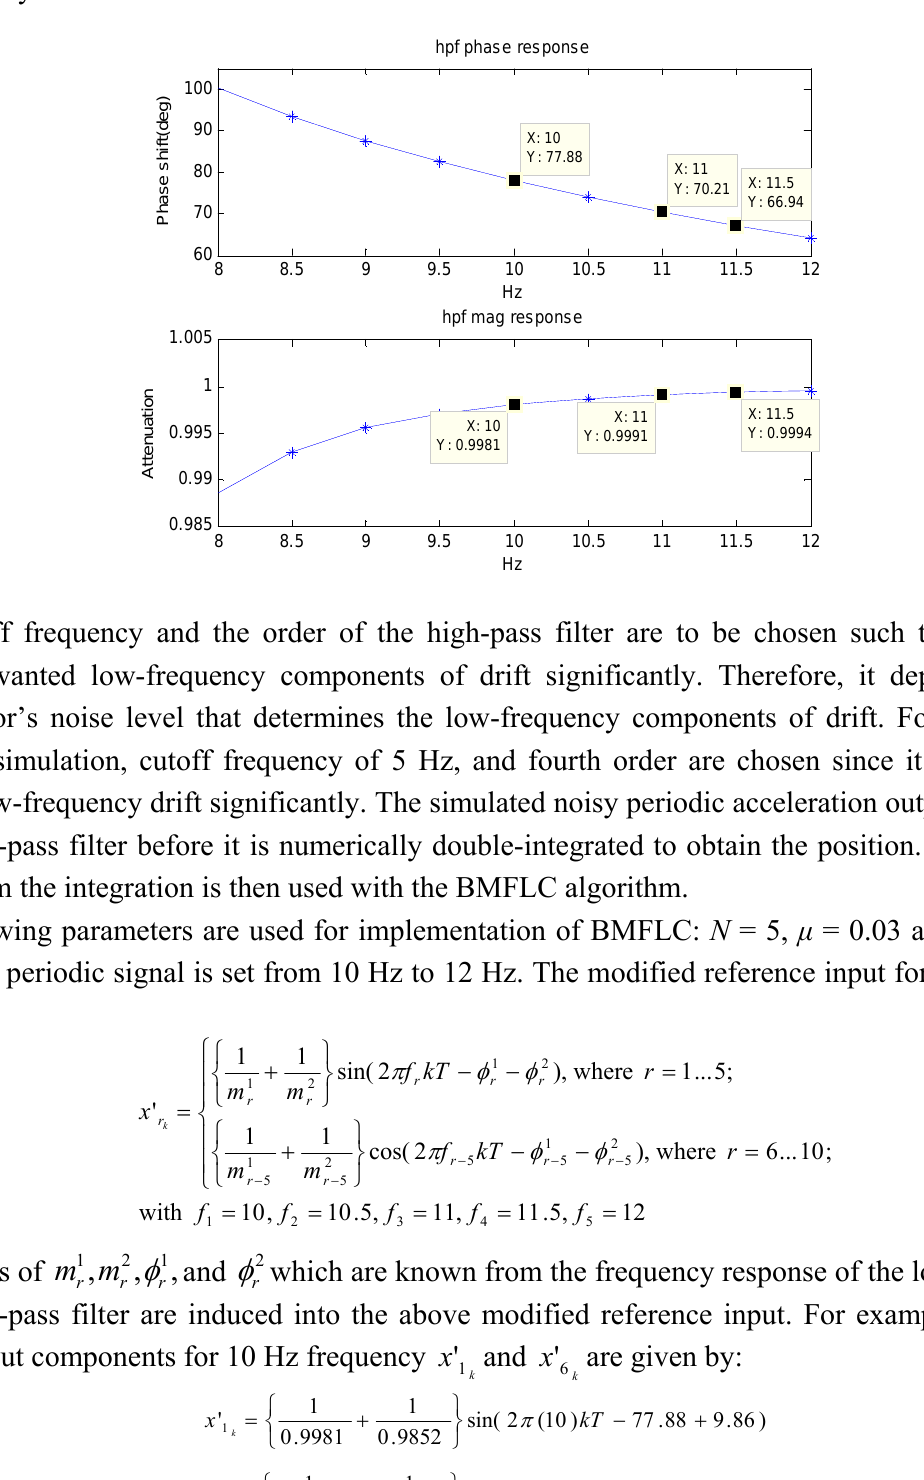
Figure 8. Frequency response of the 4th order high-pass Butterworth filter with a cutoff frequency of 5